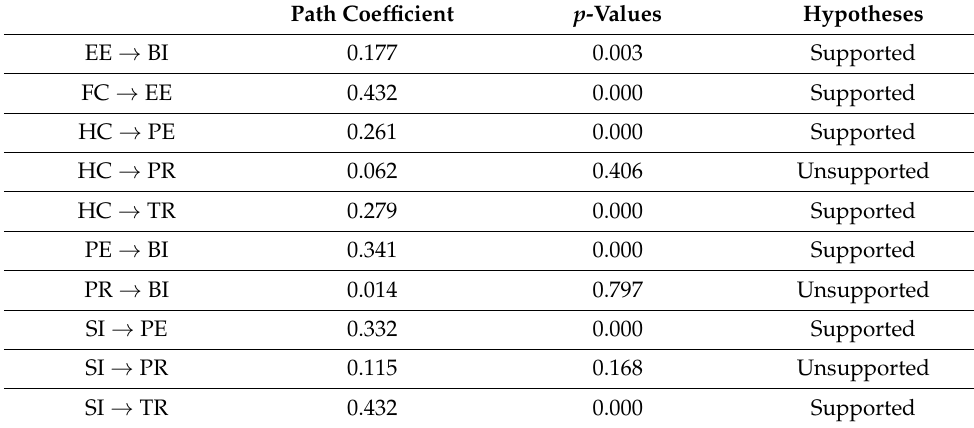
Table 5. Results of the hypothesis